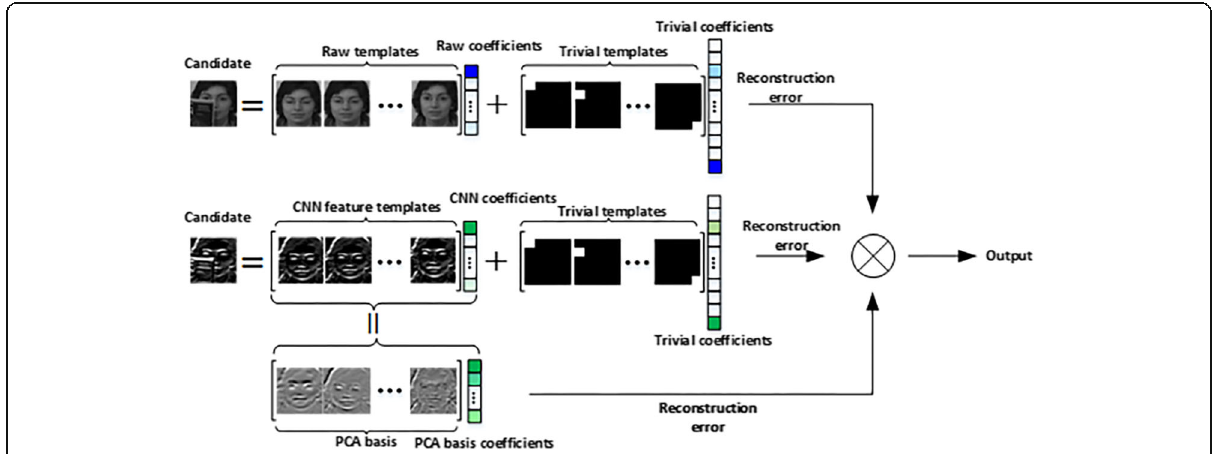
Fig. 1 Overall sparse model with CNN